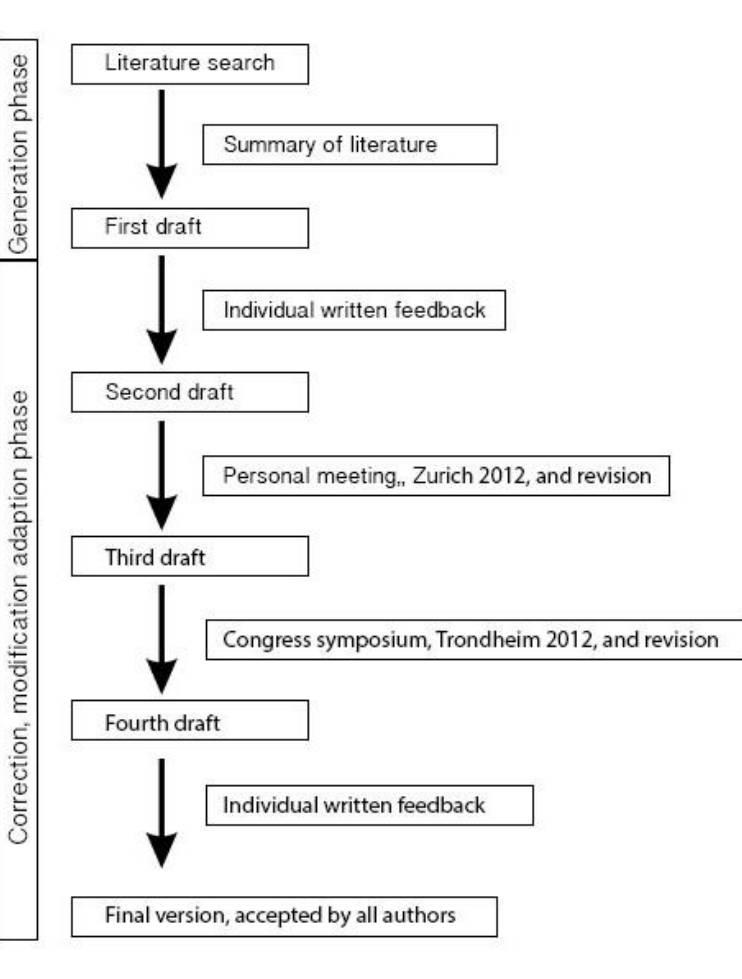
Figure 1. Description of the writing